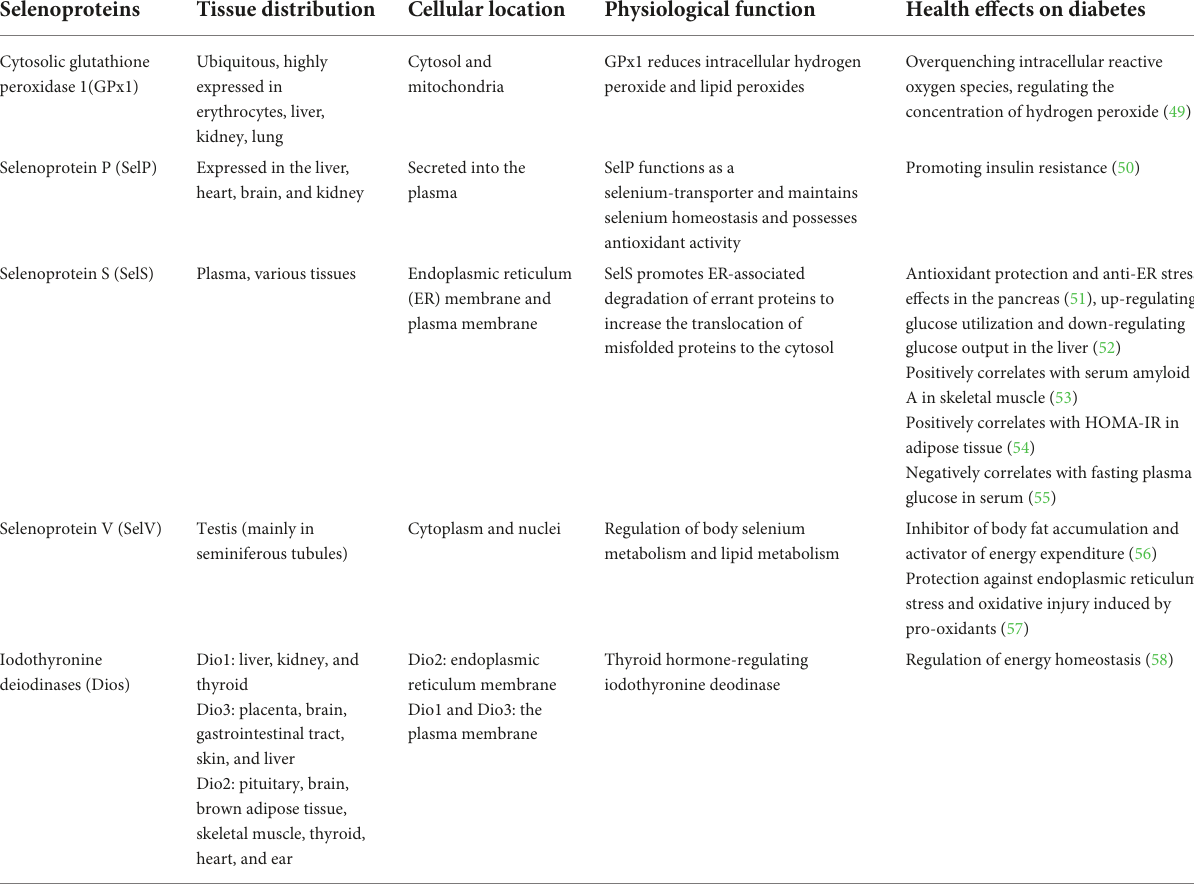
TABLE 1 Role of main selenoproteins associated with metabolism and type 2